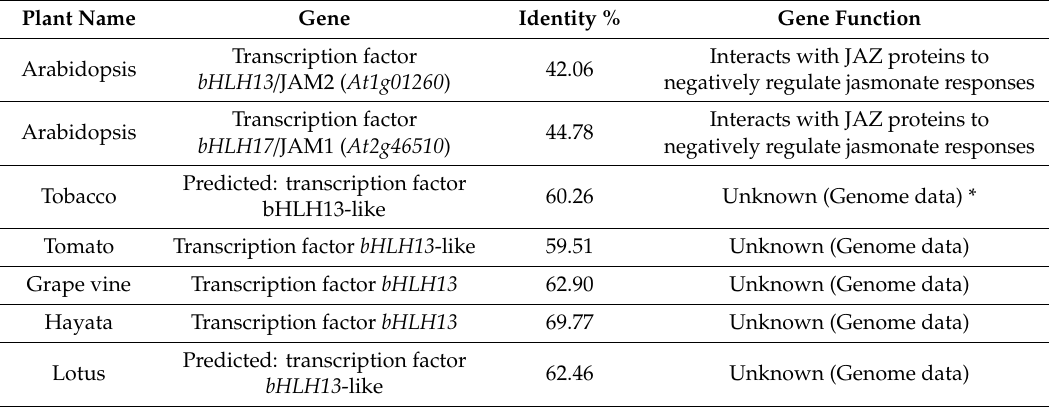
Table 2. Summary of the homology of wintersweet CpbHLH13 with genes from other plants.